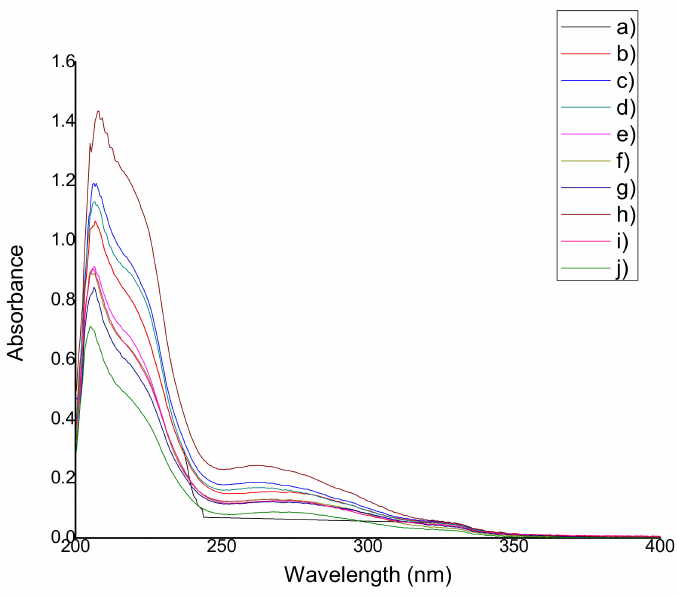
Figure 6. UV spectrum of ( a ) QS2; ( b ) QSO0.5; ( c ) QSO2; ( d ) QSO5; ( e ) QSP0.5; ( f ) QSP2; ( g )